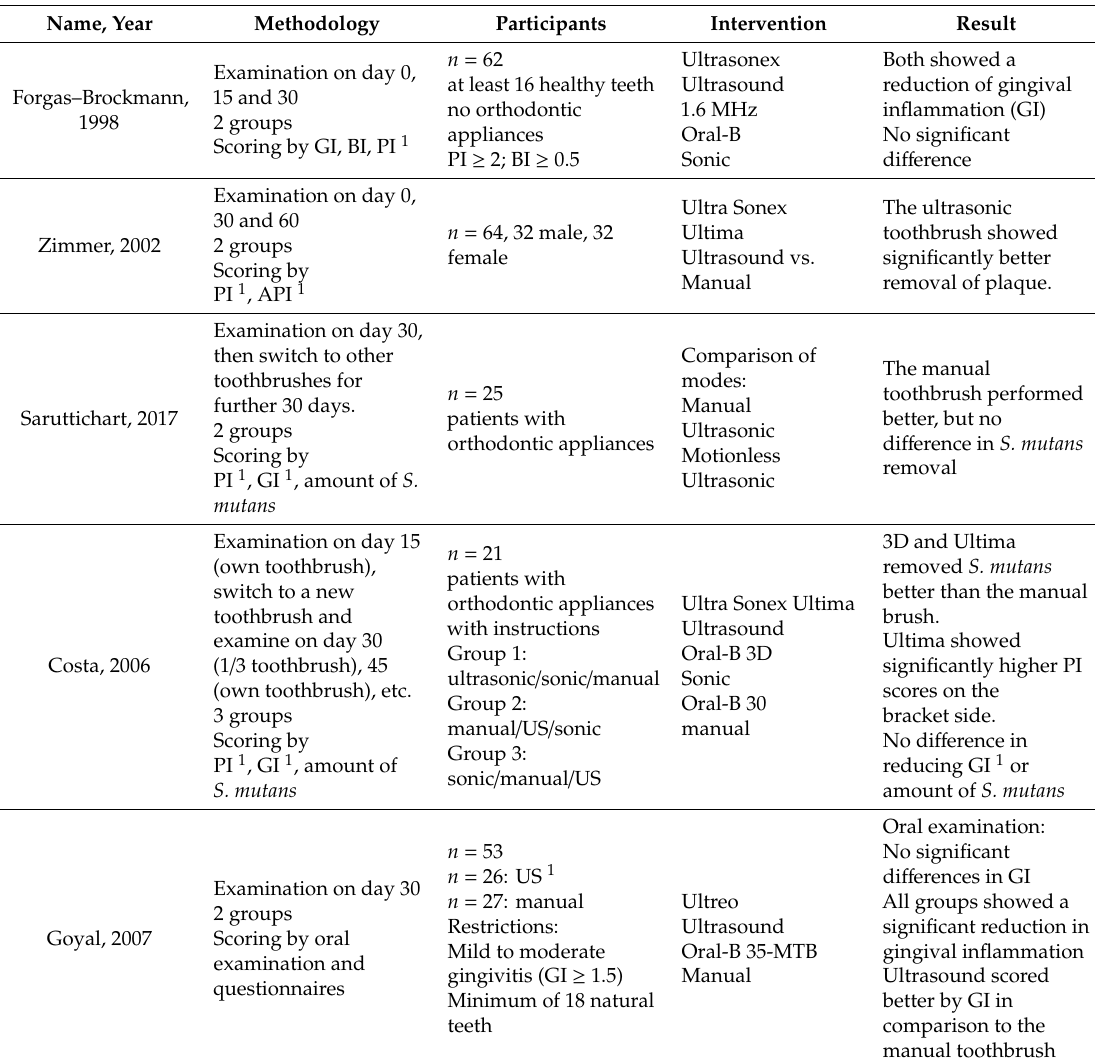
Table 2. Short-term studies on sonic toothbrushing e ff